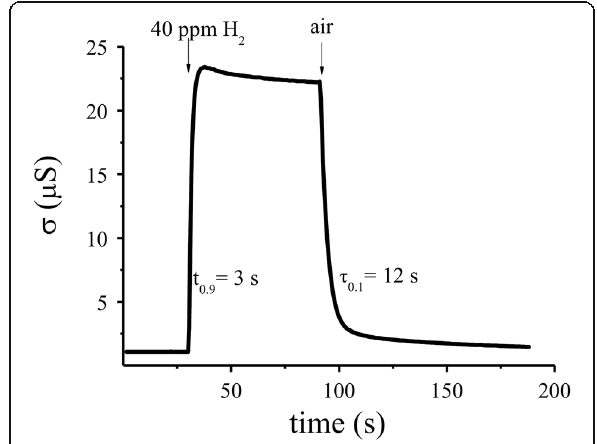
Fig. 7 Change in the conductivity versus time for the optimal Pd-doped sensor (0.09% Pd/SnO 2 ) at the sensor temperature 261 °C